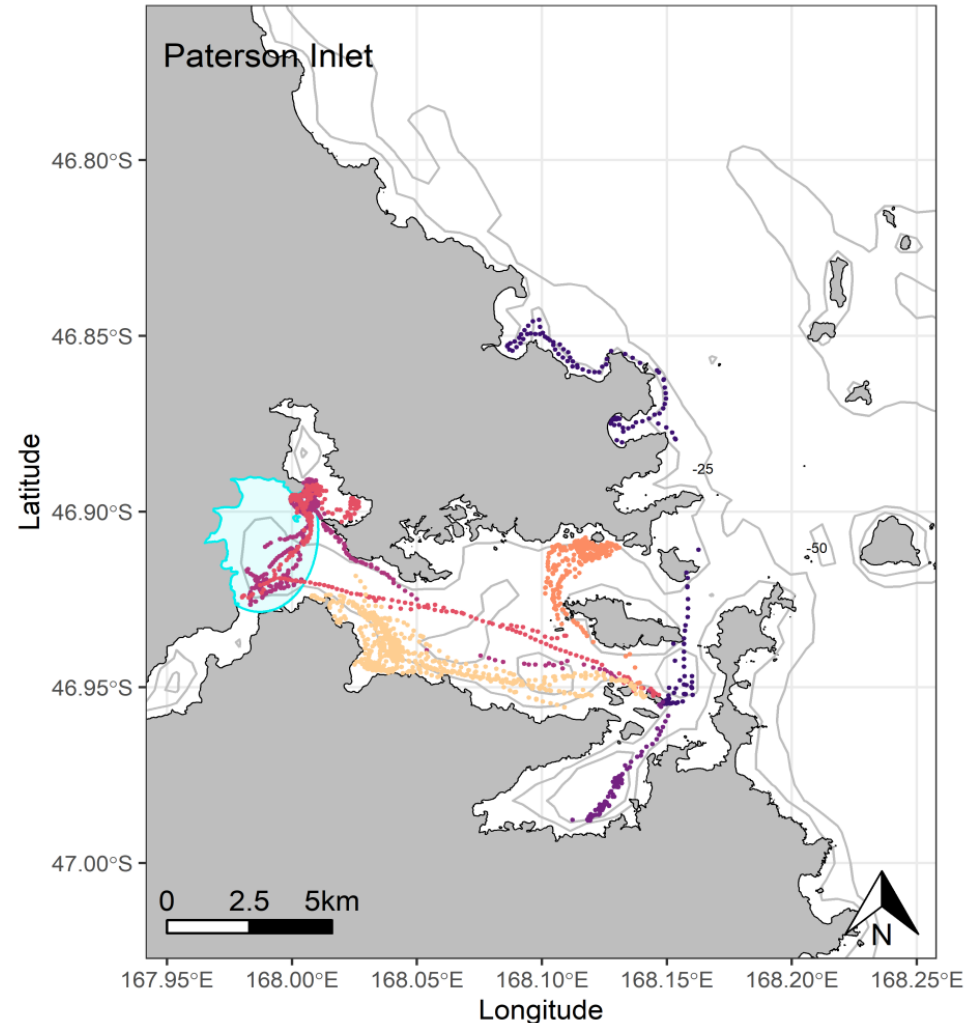
Figure 5. At-sea location fixes (travelling and foraging) of adult breeding yellow-eyed penguins during the chick-guard stage of breeding from Paterson Inlet, Stewart Island ( n = 6), 2020/21. Ka Moana e Rua, a shallow intertidal area, is highlighted in blue.